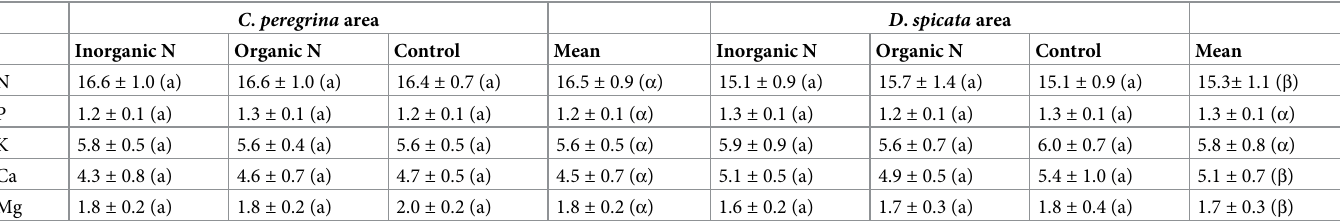
Table 3. Foliar chemistry of lowbush blueberry. Concentrations of N, P, K, Ca, and Mg (mg g -1 ) in plots having C . peregrina or D . spicata as companion species of low- bush blueberry. Values are mean ± SD. Values not sharing the same letters are significantly different ( P < 0.05). Roman letters are used to compare N-fertilization treat- ments, whereas Greek letters are used to compare the two areas of the field (i.e., C . peregrina area vs. D . spicata